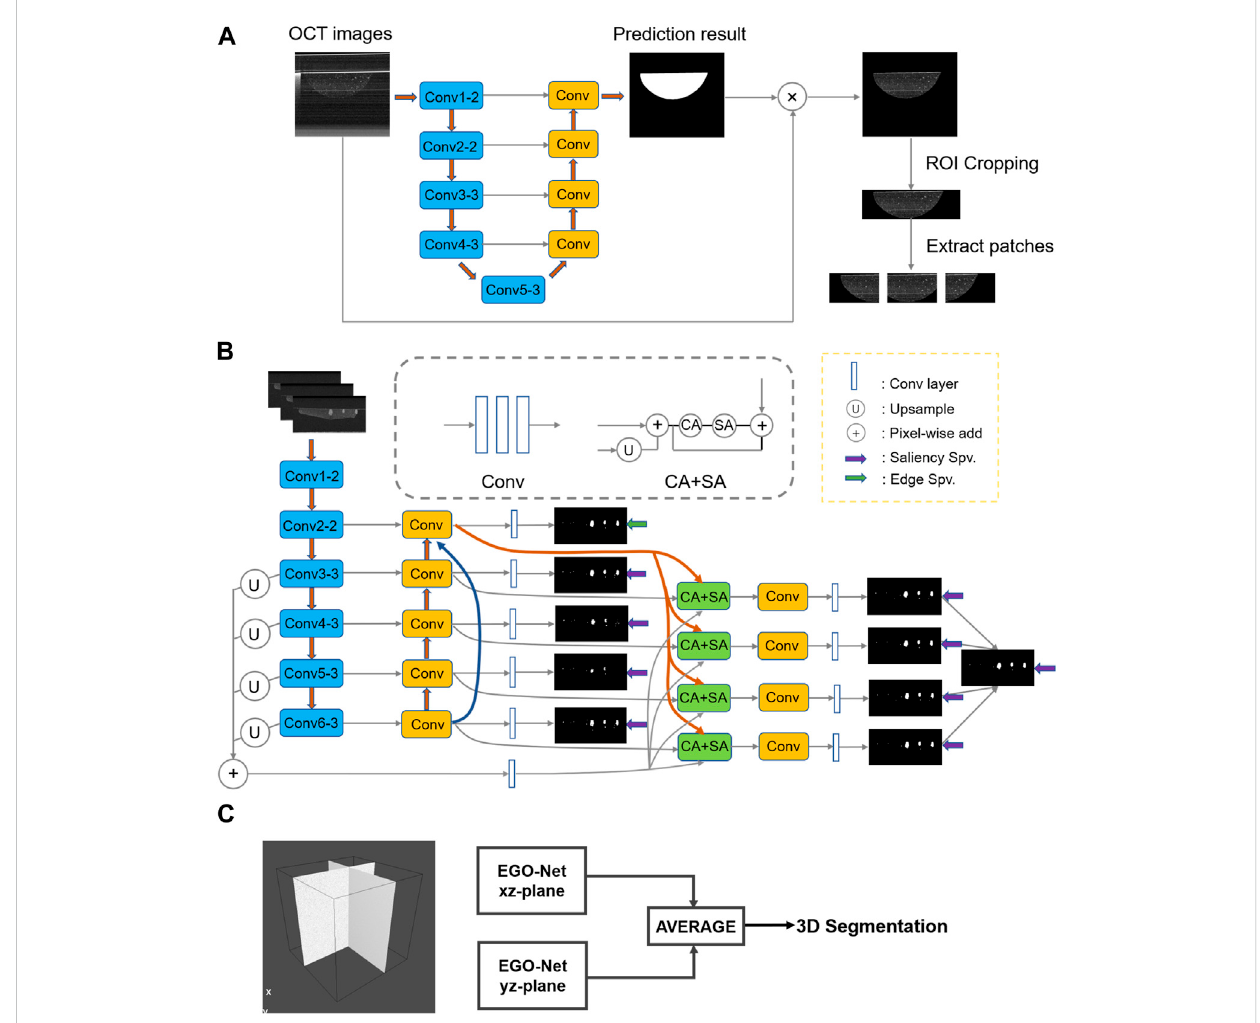
FIGURE 2 The network structure or method used in the entire segmentation process. (A) Determine the VGG-Unet structure for the region of interest microbeads. (B) Architecture of the proposed EGO-Net. (The left side shows the encoder and decoder combination with U-shaped structure. The encoder receives the image as input and generates multi-level and multi-resolution feature representations, while fusing the features after Conv2-2 to obtain multi-scale features. The decoder then receives the feature representation from the encoder to generate the corresponding predicted output, and uses the output corresponding to Conv2-2 to generate edge features. The segmentation results are obtained on the right side by fusing the multi-scale features, predicted outputs and edge features and decoding them accordingly.) (C) The fi nal 3D segmented image obtained by averaging results of two orthogonal